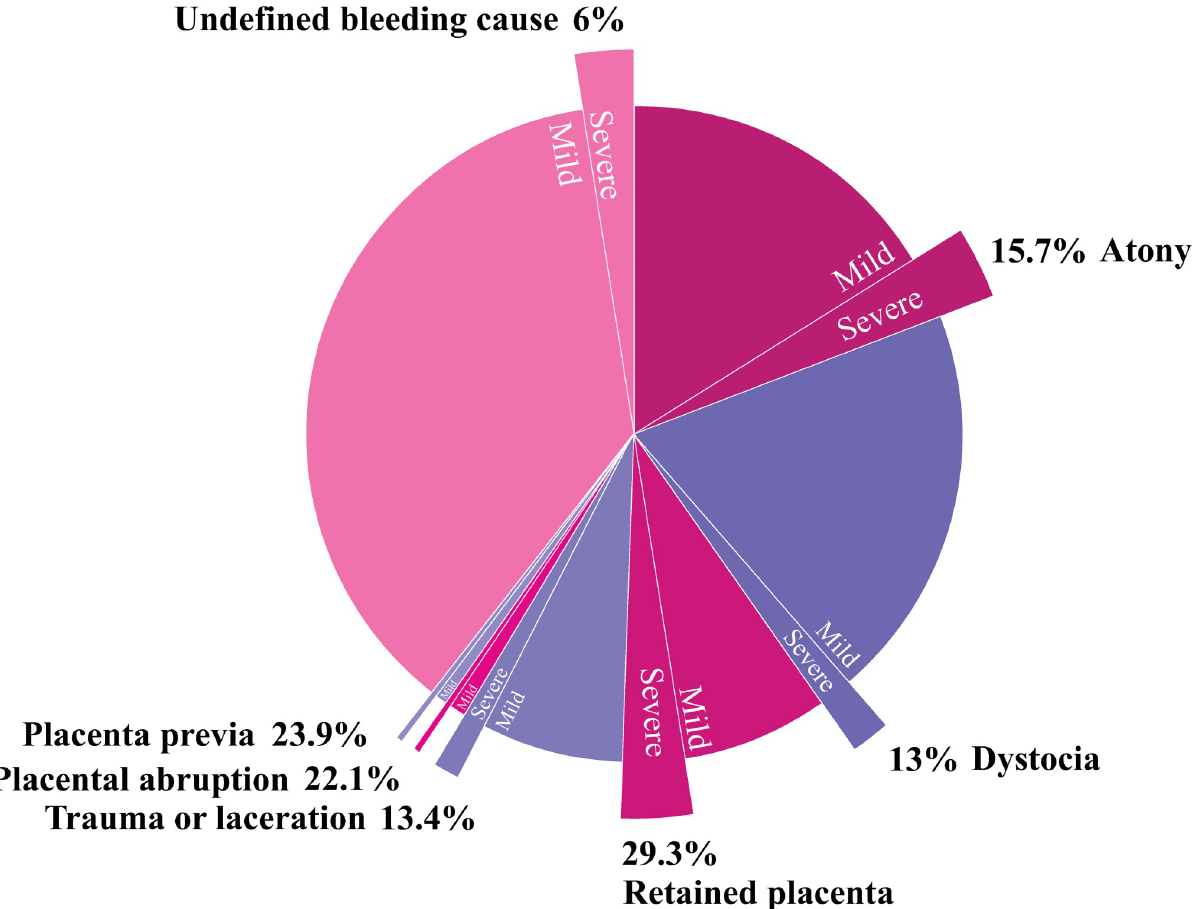
Fig 2. Proportions of severe postpartum hemorrhage ( > 1500ml) within type specific postpartum hemorrhage (1999–2017); singleton births, � 22 weeks of gestation.